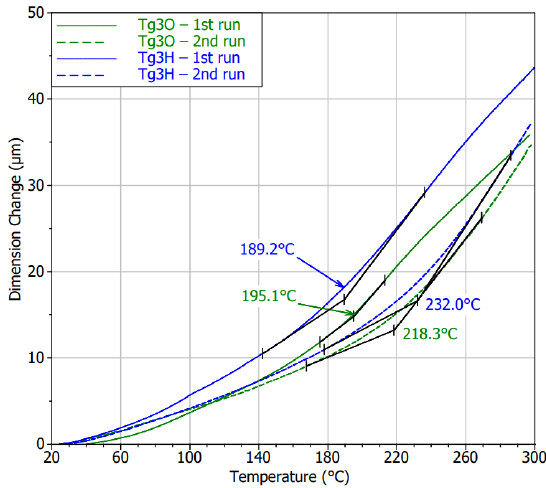
Figure 15. Comparison of the results according to the testing temperature.